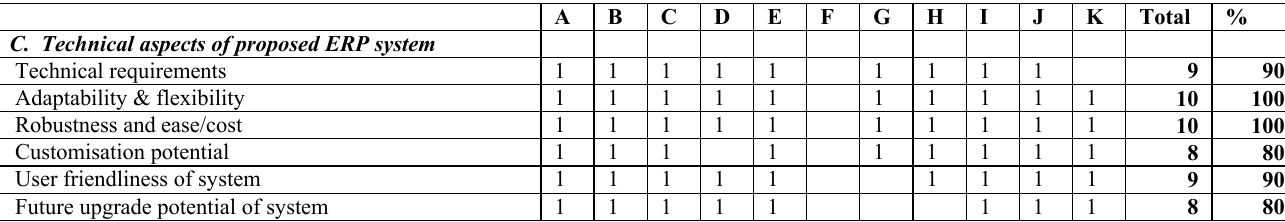
Table 5: Summary of technical aspects selection criteria considered